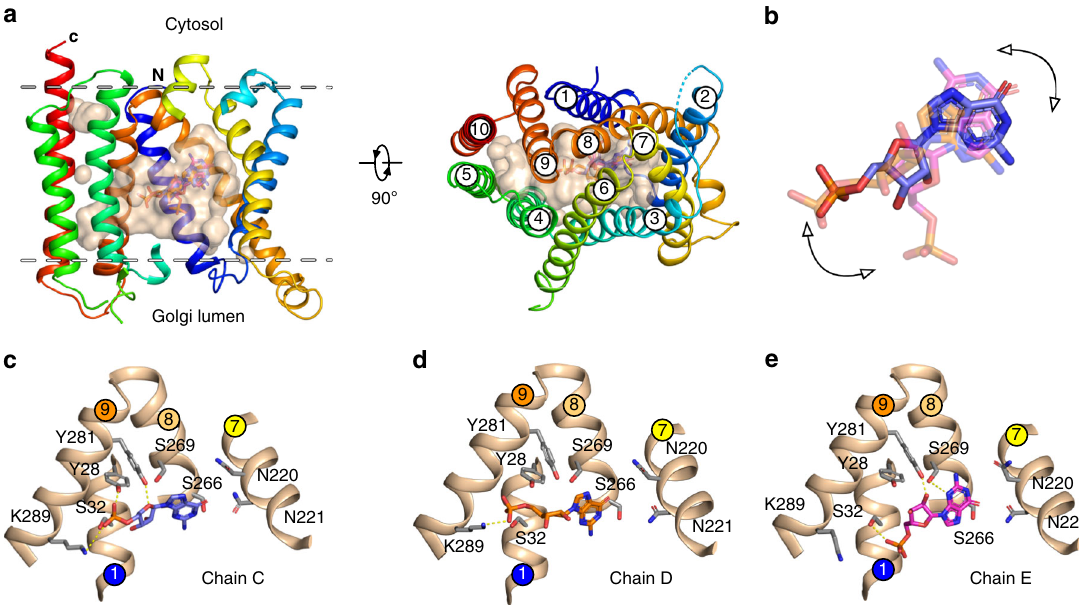
Fig. 1 Crystal structure of Vrg4 bound to GMP. a Crystal structure of Vrg4 with helices coloured blue (N-terminus) to red (C-terminus). The binding cavity is open to the Golgi lumen, and shown as a transparent surface (wheat). The three different positions observed for the GMP molecule are overlaid in blue, orange and pink. The position of the lipid bilayer is indicated by white dashed lines. b An overlay showing the three GMP molecules as presented in a , with arrows highlighting the changes in positions observed for the nucleoside and phosphate groups. c , d , e Zoomed in views of the binding site from chains C, D and E respectively, showing the different positions and interactions made to GMP in the crystal